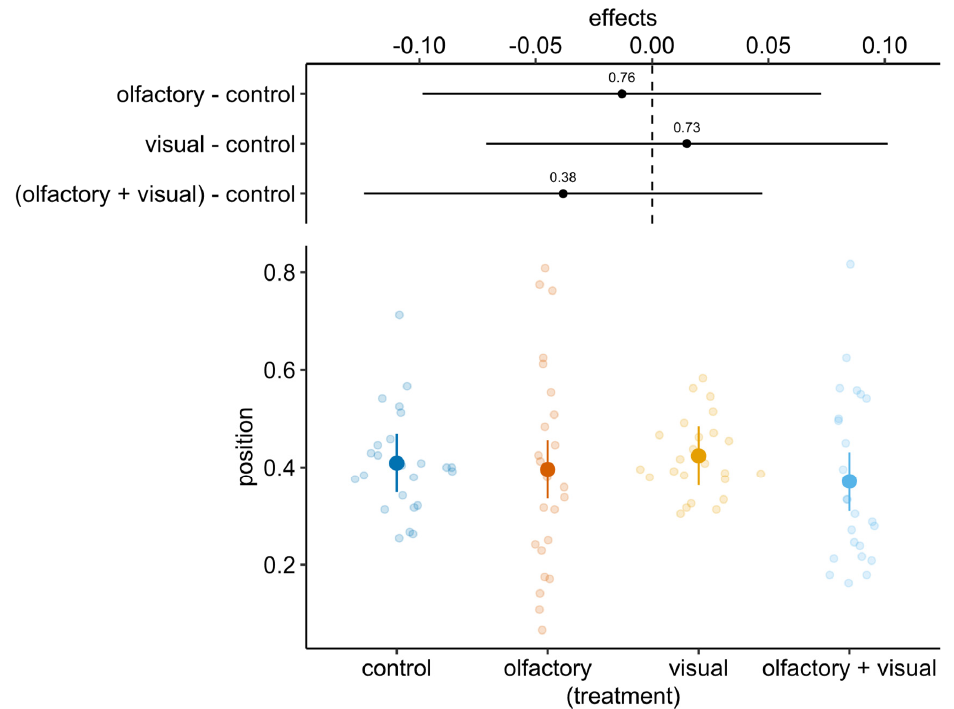
Figure 4. Estimated means of tadpole post-stimulus position (larger coloured points) and relative 95% CI (vertical bars) from the mixed model. Coloured dots indicate estimated individual means, where values below 0.5 indicate a preference for the portion of the arena which contains the trans- parent container. The top of the plot shows the estimated effects (difference) in comparison with control treatment (absence of both predator visual and olfactory cues); estimates not overlapping with the vertical dashed line (i.e., difference = 0) indicate significant difference in comparison to control treatment.